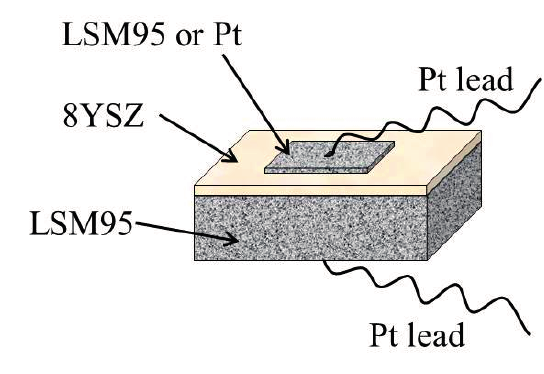
Figure 1. Schematic illustration of the NO 2